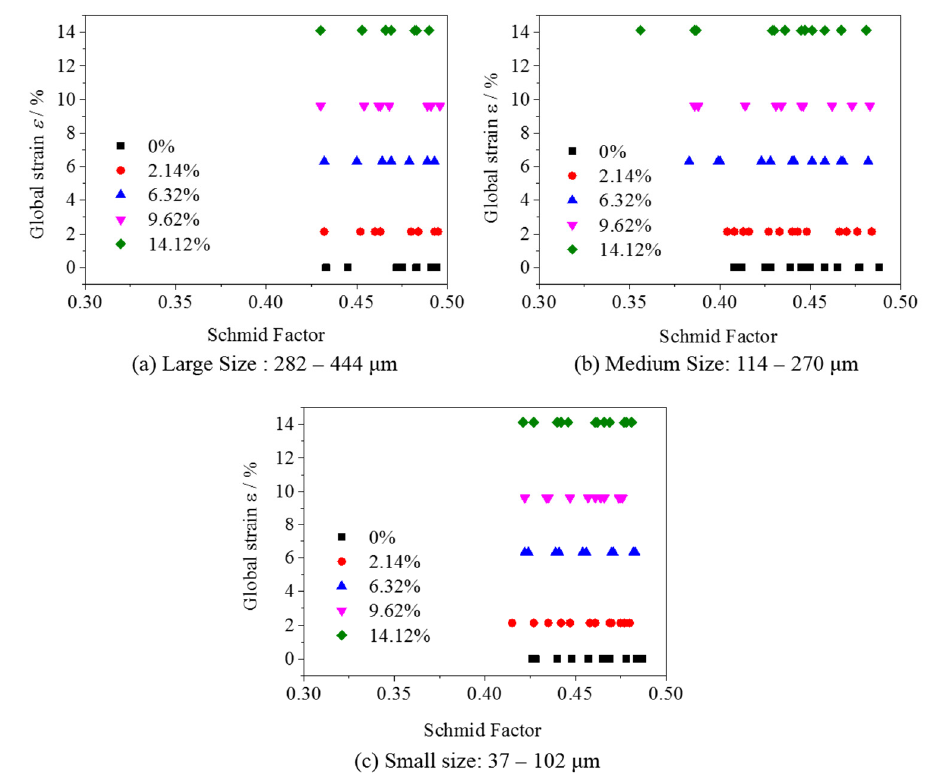
Figure 7. Statistics of Schmidt factors of the observable field observed by EBSD.